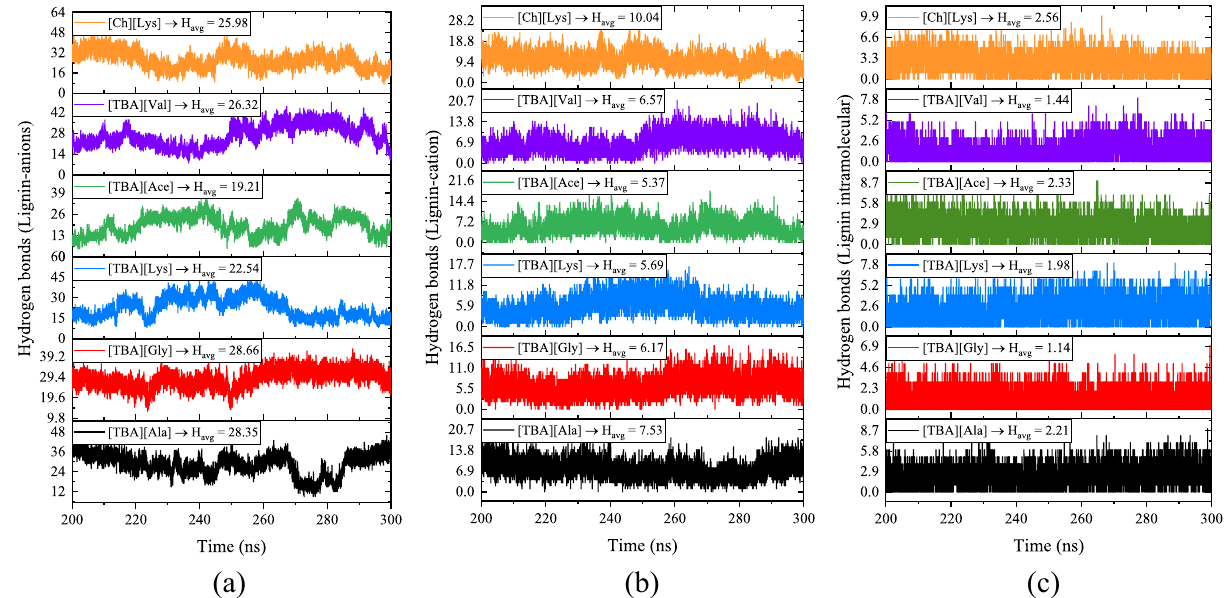
Figure 12. MD calculated average number of hydrogen bonds between the ( a ) lignin-anion, ( b ) lignin-cation, and ( c ) within the lignin molecules in different IL-lignin systems. Origin 2020 SR1 software is used to draw this plot (https:// www. origi nlab. com/